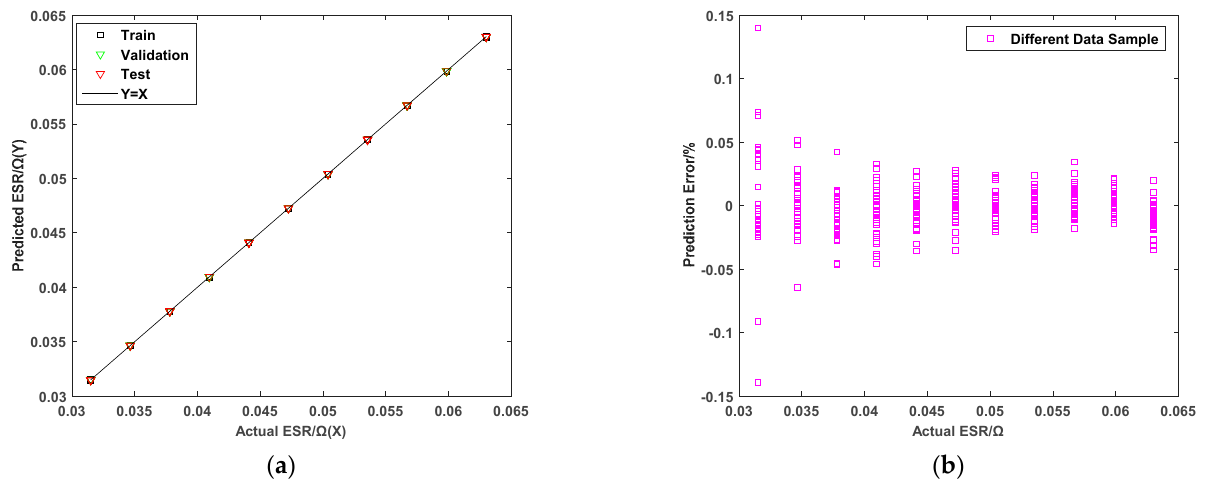
Figure 6. ESR Estimation results by ANN when N ESR = 10 ( a ) a best fitting showing train, test and validation results; ( b ) cross validation showing PEs for 10 fittings under 10 random data divisions.